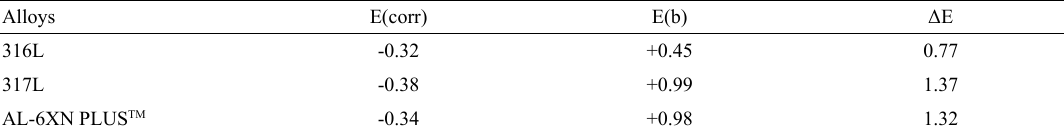
, E and ΔE in V (Ag/AgCl). corr b